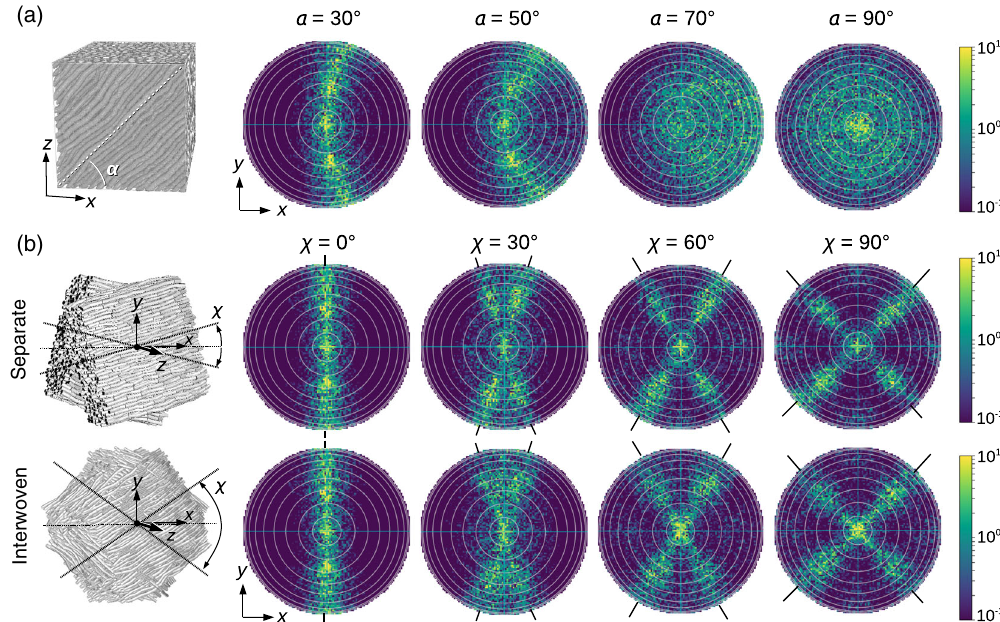
FIG. 7. Simulated scattering patterns for different artificial nerve fiber constellations: (a) densely grown fiber bundle [cf. Fig. 3(b)(i)] with different inclination angles α and (b) in-plane crossing fibers [separate and interwoven bundles; cf. Figs. 5(a) and 5(b)] with different crossing angles χ . The scattering patterns show the underlying substructure, e.g., the crossing angle of the fibers (indicated by the black lines around the